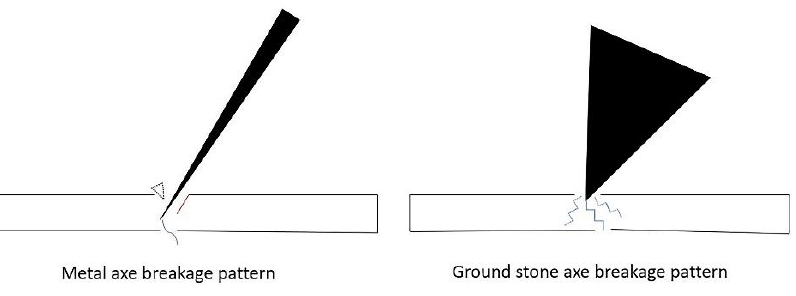
Figure 13. Schematic of metal vs. ground stone fragmentation pattern.